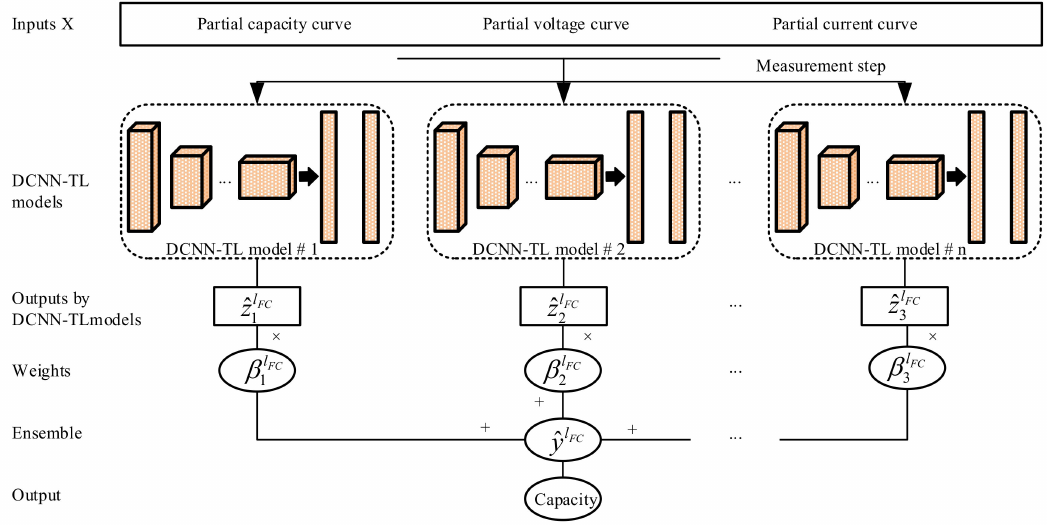
Figure 6. The flowchart of the iterative DCNN-based residual capacity